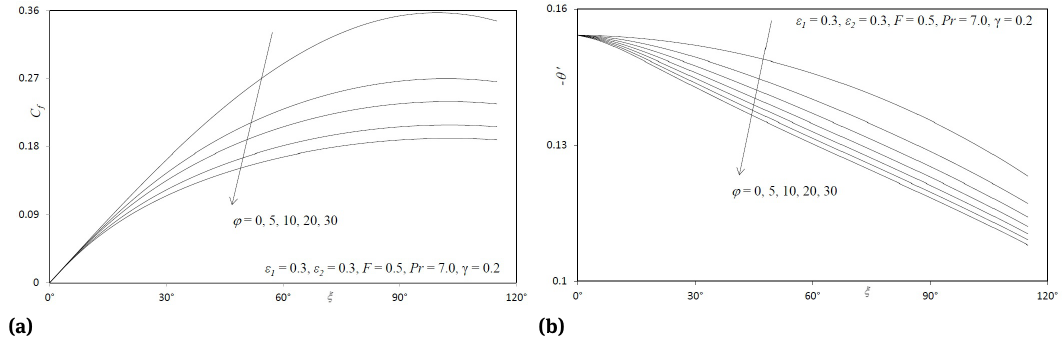
Fig. 9: (a) Effect of φ on Skin Friction; (b) Effect of φ on Nusselt